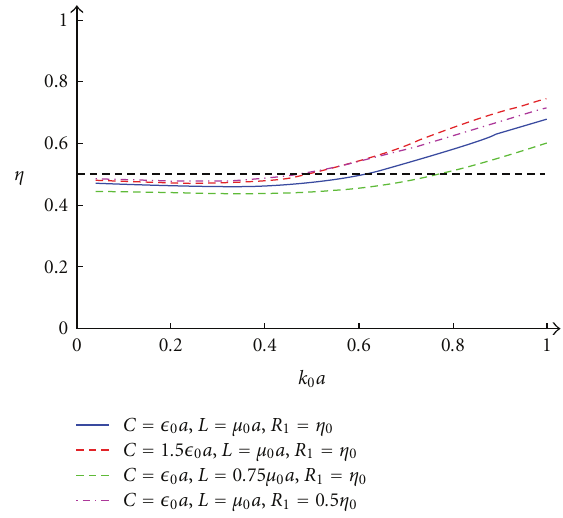
Figure 3: The generalized absorption e ffi ciency for the idealized dipole antenna (4) and (10) and various values of C , L , and R 1 as function of the normalized resonance wavenumber k 0 a